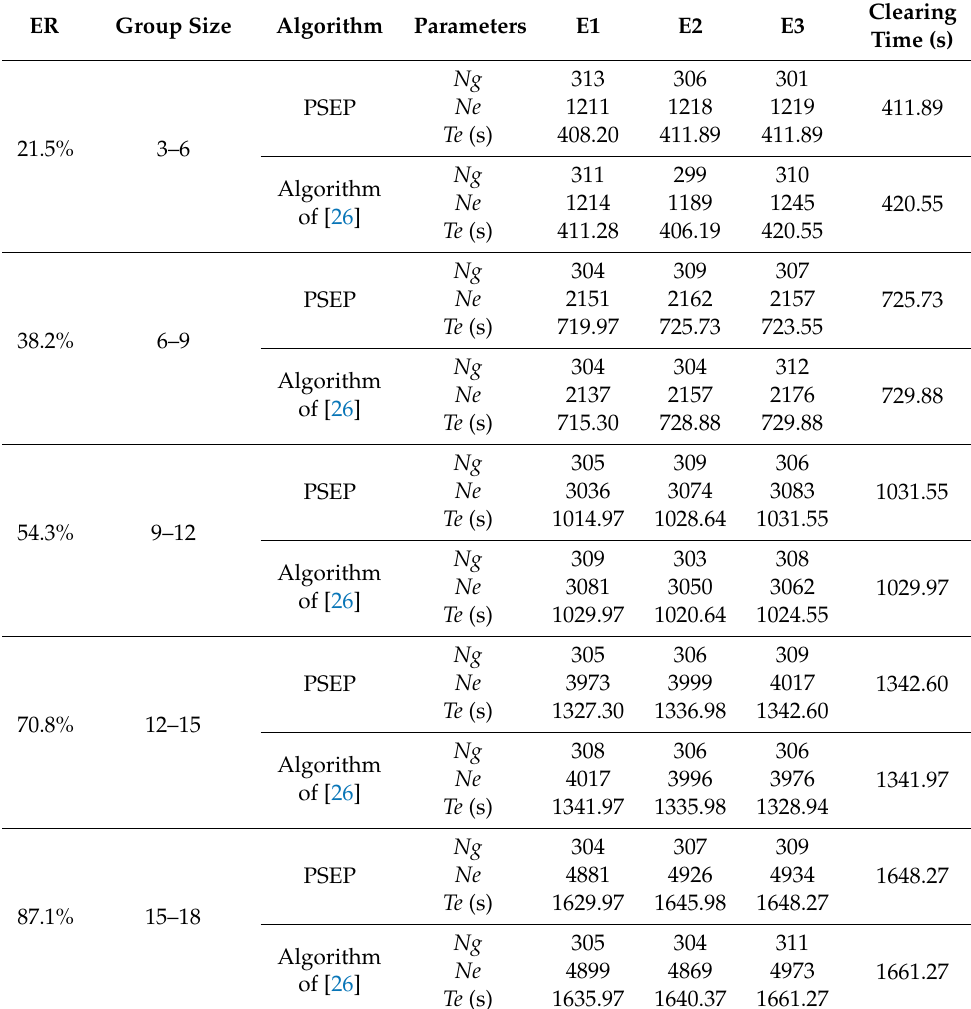
Table 7. The test results when the group size is